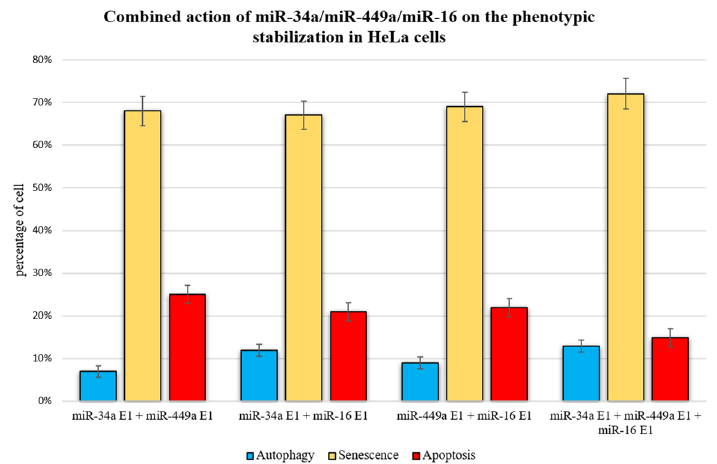
Figure 5. Integration of miR-34a, miR-449a, and miR-16 on the phenotypic stabilization in HeLa cells. The First synergy case between overexpression (E1) of miR-34a E1/miR-449a E1. The second synergy case between miR-34 E1/miR-16 E1 overexpression (E1). Whereas, the third case between miR-449a E1/miR-16 E1. At the last, all these miRNAs overexpressed (E1) together i.e., miR-34a E1/miR-449a E1/miR-16 E1. Each particular color bar denotes its corresponding phenotype. For each case, we have run 10.000 Monte Carlo simulations. In addition, the first three cases are compared with the last case of synergy. For more detail see "Integration of miR- 34a/miR-449a/miR-16 on the phenotypic stabilization at the G1/S checkpoint" section.